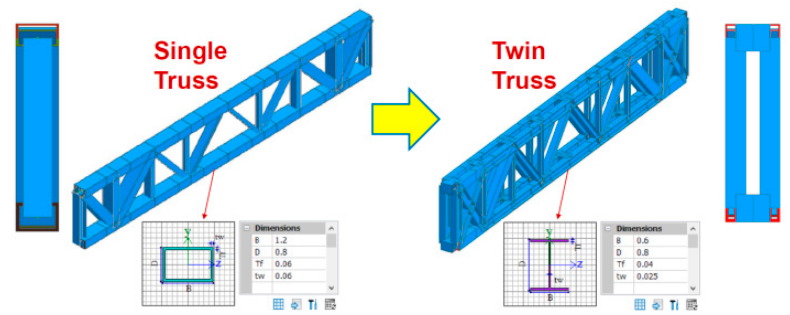
Figure 4. Original single truss vs. optimal twin truss. Table 2. Comparison of member section types.